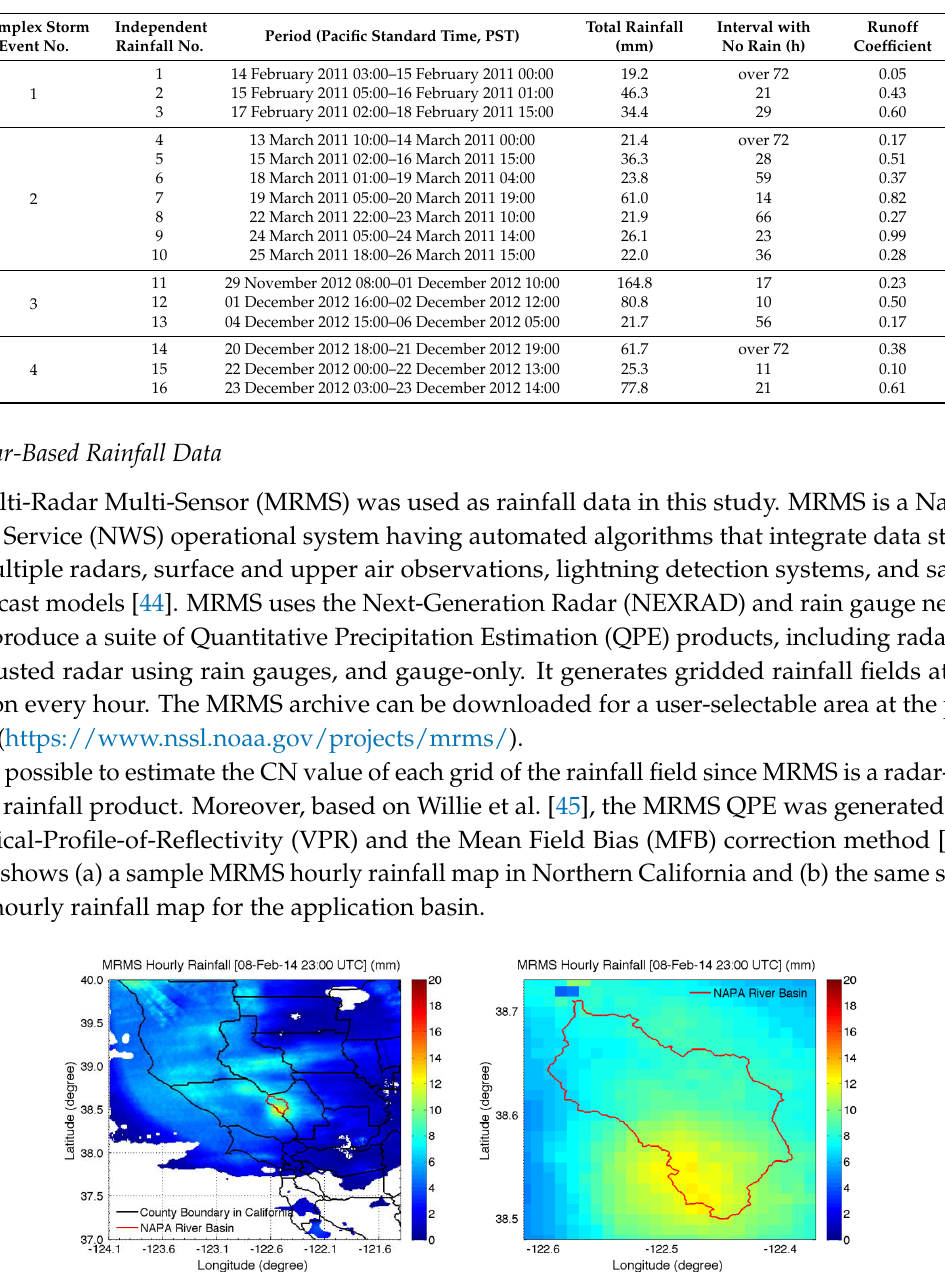
Table 2. Characteristics of the applied storm events.